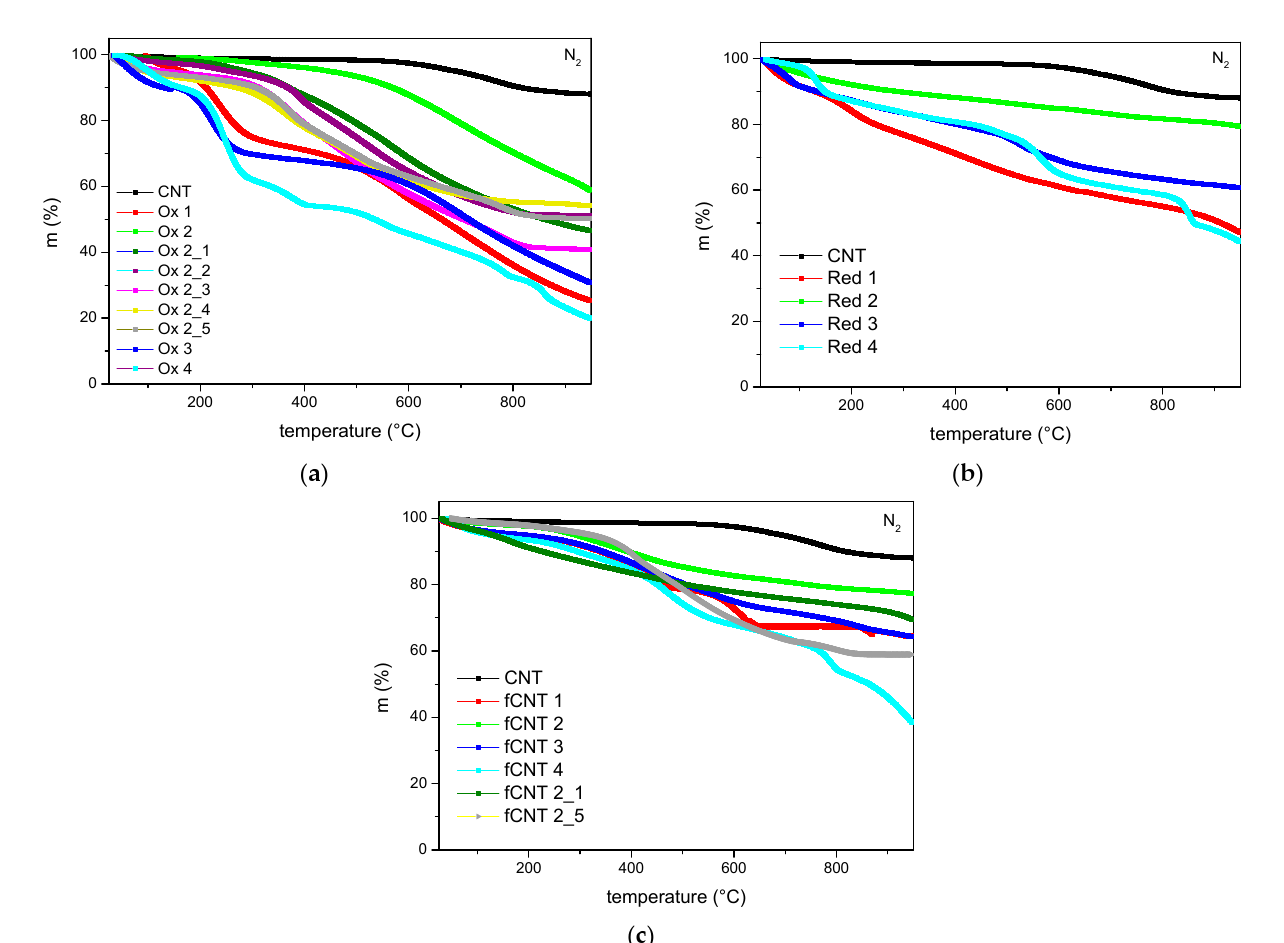
the carbon nanotubes. To prevent further oxidation, N 2 remained the carrier gas for the whole experiment.